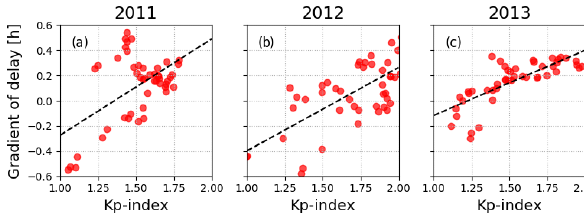
Figure 5. The scatter plots for 2011 (a) , 2012 (b) , and 2013 (c) show the correlation between the Kp index and gradient of the delay. The smoothed weekly means (running mean with window size of 10d) are used for this comparison. Correlation coefficients of ≈ 0 . 53 (a) , ≈ 0 . 70 (b) , and ≈ 0 . 77 (c) are estimated. All data correspond to the location of Rome at 41.8 ◦ N, 12.5 ◦ E.